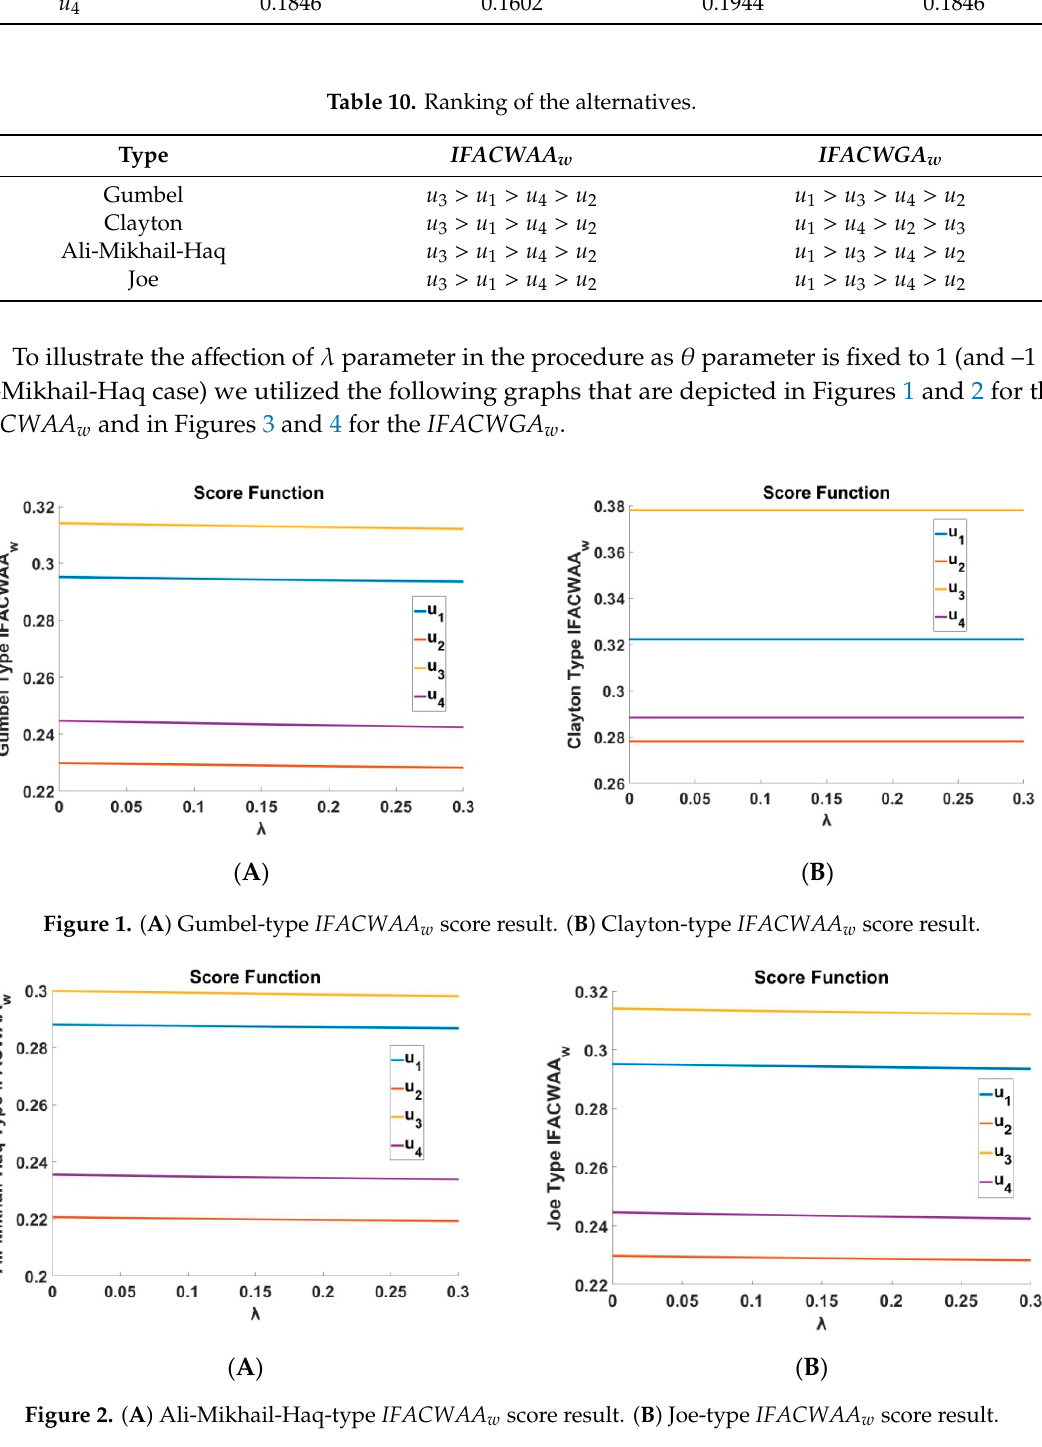
Table 10. Ranking of the alternatives.